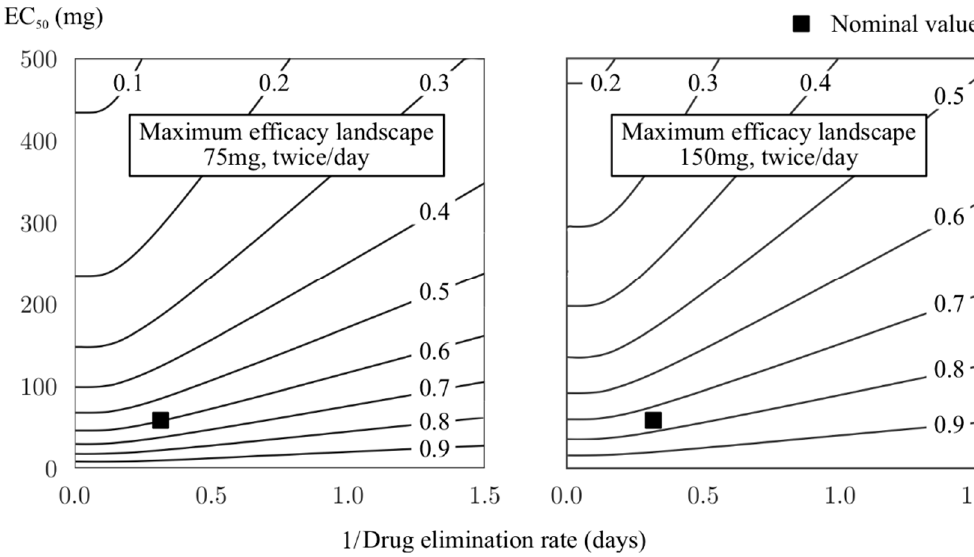
Figure 5. Maximum efficacy landscape of oseltamivir with respect to the drug parameters. The two recommended regimens, curative (75 mg, twice/day) and epidemic use (150 mg, twice/day), are shown. Contour lines mark the level of efficacy that can be theoretically achieved given a combination of the drug elimination rate and half-maximum concentration. The nominal value indicates the efficacy calculated based on currently reported values of the two parameters [20].